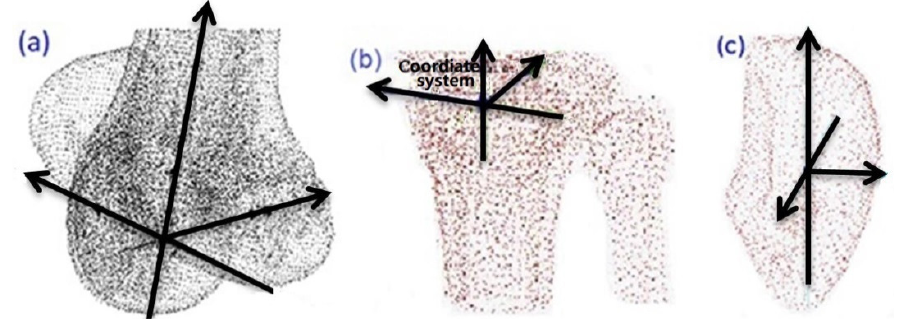
Figure 4. Coordinate system of bone. ( a ) femur; ( b ) tibia; ( c ) patella. 96